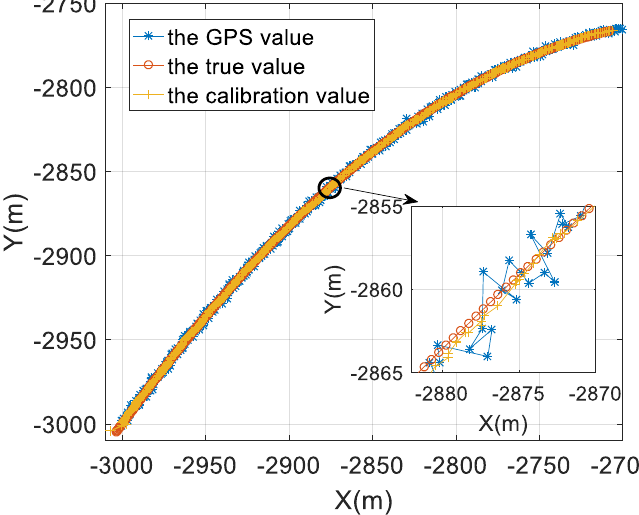
Figure 6. The analysis result of the modem position of buoy 1.